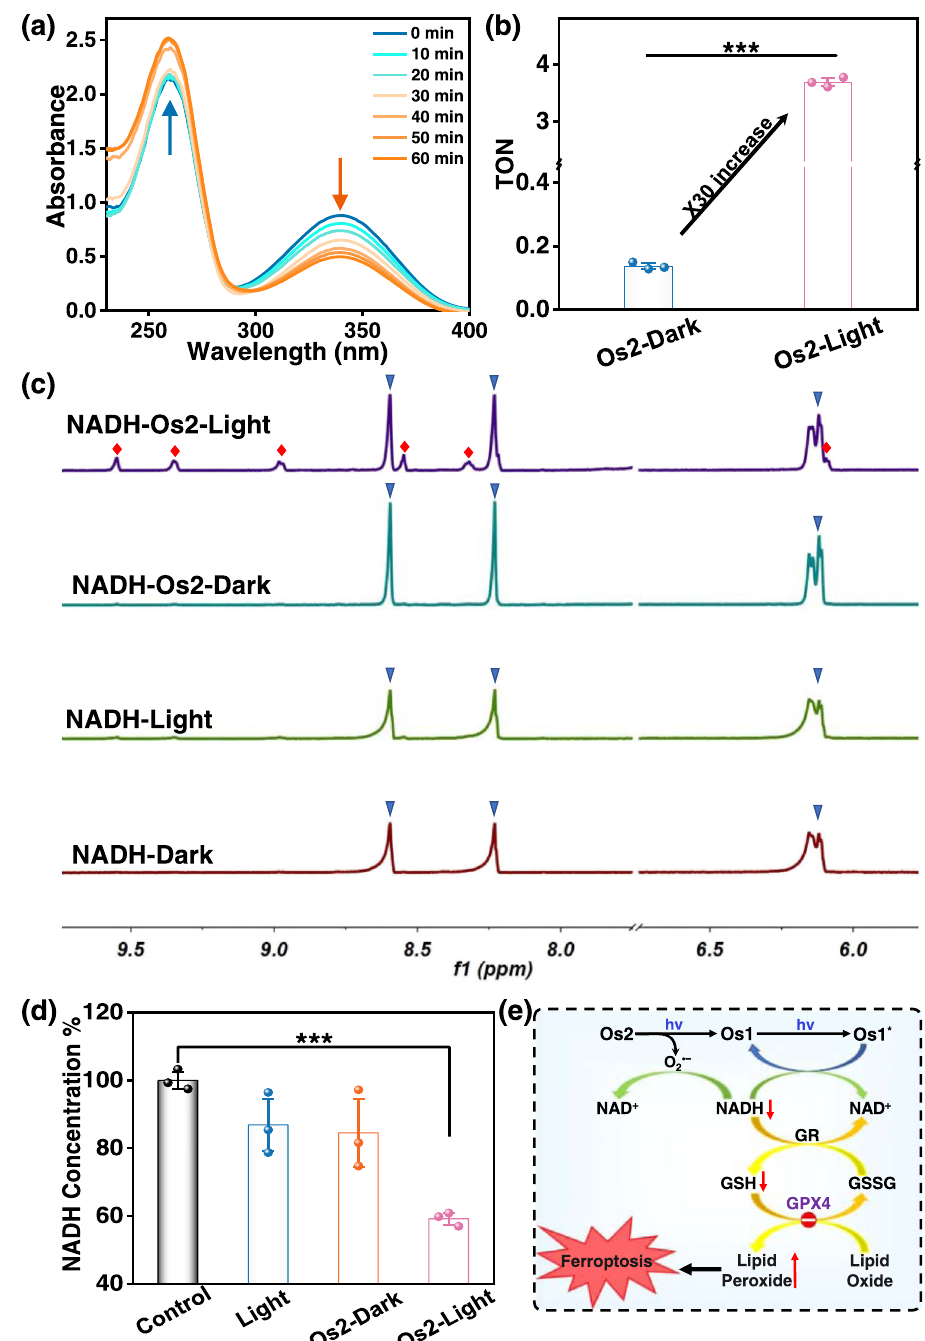
Fig. 6 Photocatalytic oxidation of NADH by Os2 under light irradiation. a Reaction of Os2 (20 μ M) and NADH (175 μ M) in PBS solution under blue light irradiation monitored by UV – Vis absorption spectra at 298 K. b TON of Os2 under dark or irradiation conditions ( n = 3 independent experiments, p = 0.0000016). c Photocatalytic oxidation of NADH (3.5 mM) by Os2 (0.25 mM) under dark or irradiation conditions monitored by 1 H NMR spectroscopy at 298 K. Peaks associated with blue triangles represent NADH, those with red squares represent NAD + . d NADH concentrations in the treated HeLa cells. Os2: 20 μ M, 310 K, 8 h. All the experiments were performed as duplicates of triplicates ( n = 3 biologically independent samples, p = 0.000039). Error bars represent S.D. from the mean. Statistical signi fi cance was calculated with two-tailed Student ’ s t test (* p < 0.05, ** p ≤ 0.01 or *** p ≤ 0.001). e Schematic diagram of the photocatalytic oxidation of NADH by Os2 and followed by induced ferroptosis. Light irradiation: 465 nm, 13 mW/cm 2 . TON turnover number, NADH 1,4-dihydro-nicotinamide adenine dinucleotide, GSH glutathione; GSSG oxidized glutathione, GPX4 glutathione peroxidase 4, GR glutathione